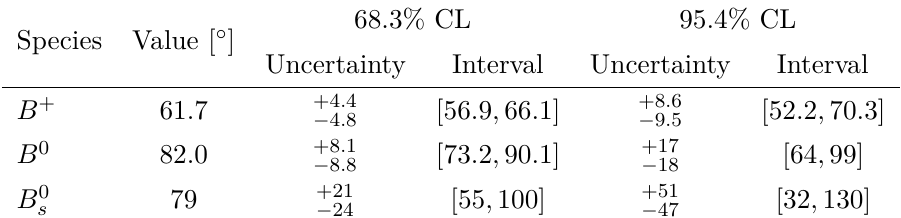
Table 4 . Confidence intervals and best-fit values for γ when splitting the combination inputs by initial B meson species.